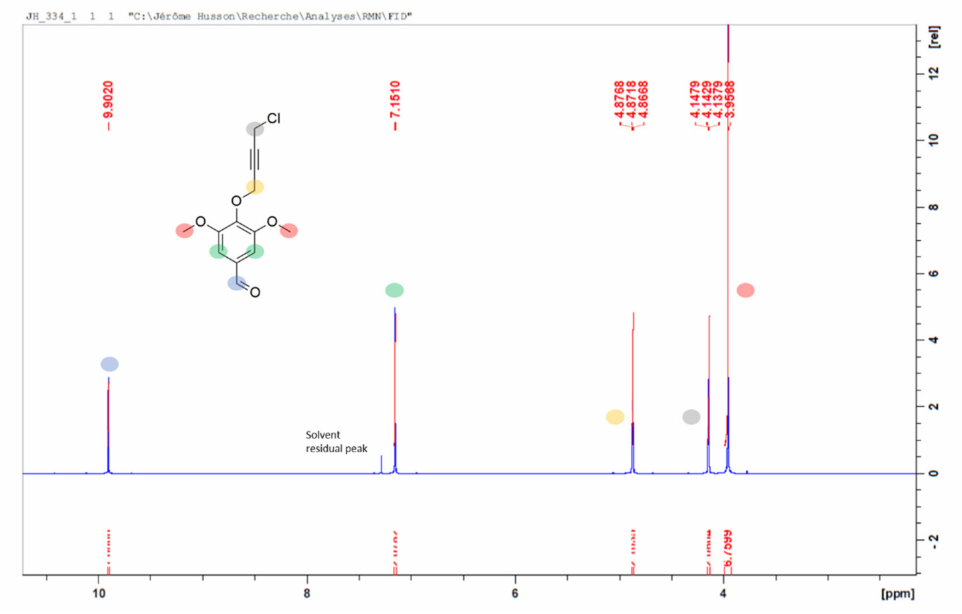
Figure 5. 1 H-NMR spectrum of compound 1